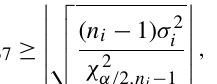
Table 1. Details of the three correlation metrics applied, adapted from Wilks (2011). All three metrics yield values between − 1 and 1. Correlation metrics Robust and resistant Description Pearson’s correlation coefficient ( r ) No Calculate the covariance of x and y , divided by the product of σ ’s of x and y . Yes Transform x and y values into ranks within x and y themselves, correlation coefficient ( r s ) then calculate the covariance of ranks in x and y , divided by the product of σ ’s of ranks in x and y . − 1) Kendall’s tau, or Kendall’s rank corre- Yes Match all data pairs between x and y , with n ( n matches pos- 2 lation coefficient ( τ ) sible with a sample size of n . Define concordant pair as both x 1 larger than x 2 and y 1 larger than y 2 , or both x 1 smaller than x